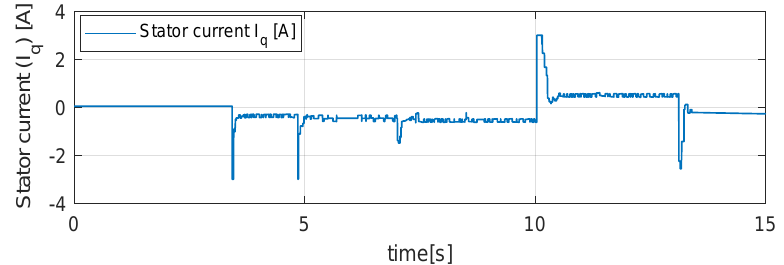
Figure 12. Stator quadrature current (experimental test IV).